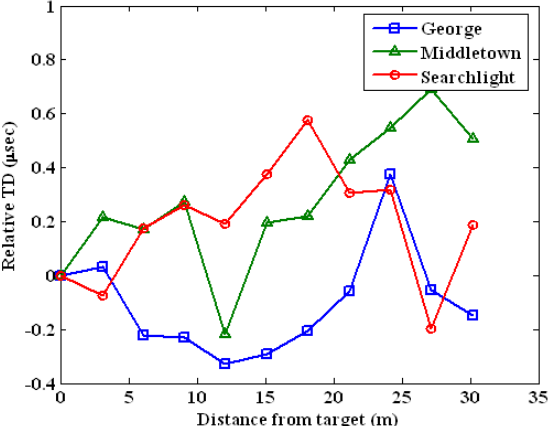
Figure 8. Spatial variation of TD measurements collected in a parking structure.